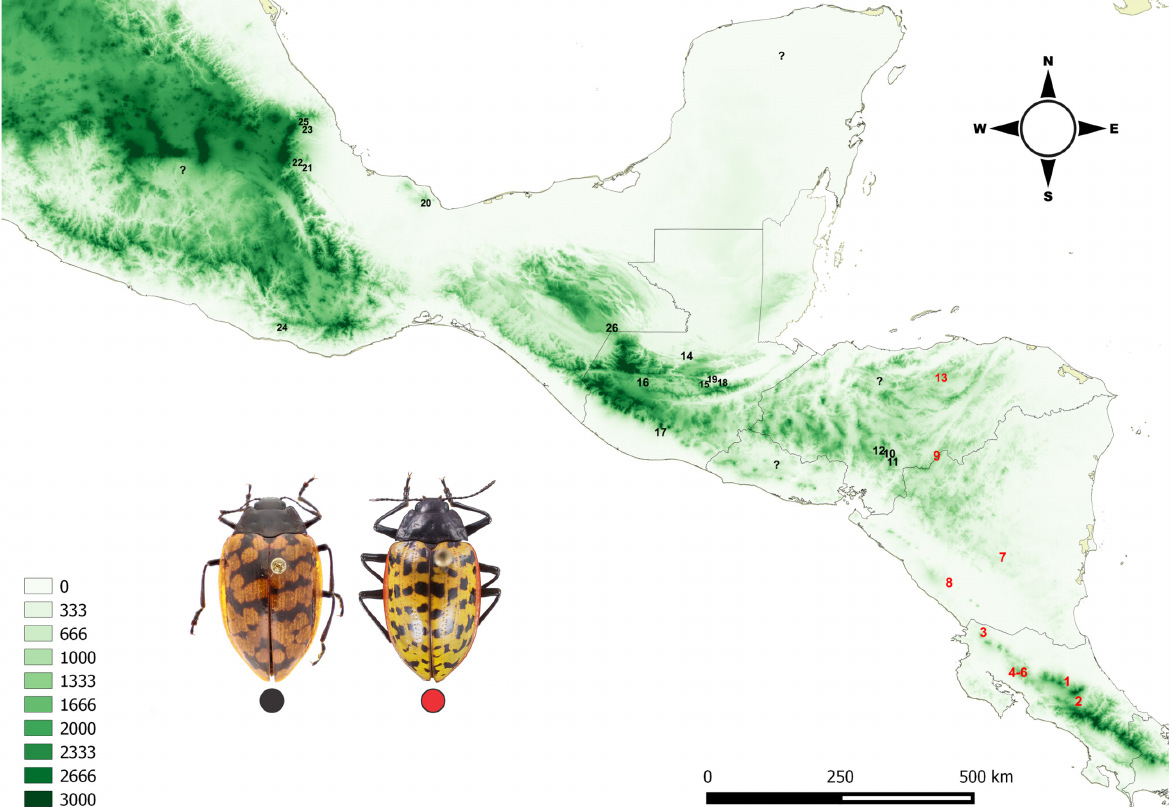
Figure 6. Geographical distribution of Erotylina leoparda (Lacordaire, 1842), at different altitude intervals (m). Numbers indicate localities listed in Table I and question marks indicate inaccurate records. Red numbers correspond to variation nicaraguae and black numbers to variation leoparda